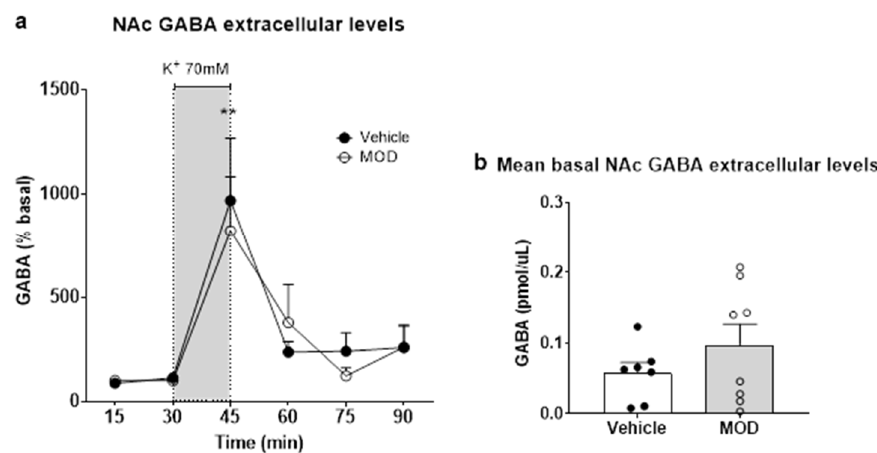
Figure 2. Effect of chronic MOD treatment on extracellular and release of GABA levels in the nucleus accumbens (NAc) after 70 mM K + stimulation by in vivo microdialysis. ( a ) Forty-five minutes after beginning the collection of samples, an aCSF containing 70 mM K + was perfused through the dialysis probe for 15 min. GABA is expressed as a percentage of baseline. Basal GABA levels (pmol/ µ L) for the vehicle were 0.063 ± 0.006 and vehicle K + 0.476 ± 0.115; MOD basal 0.898 ± 0.413 and MOD K + 1.206 ± 0.498; vehicle ( n = 7) and MOD ( n = 5); ** p < 0.01; ( b ) GABA release levels in the NAc is expressed the mean of GABA levels ± SEM.